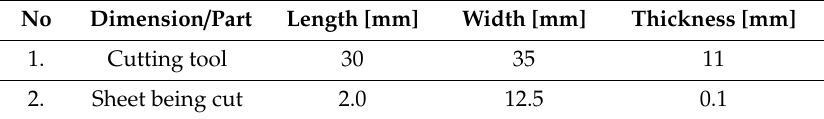
Table 3. Dimensions of a cutting tool and sheet being